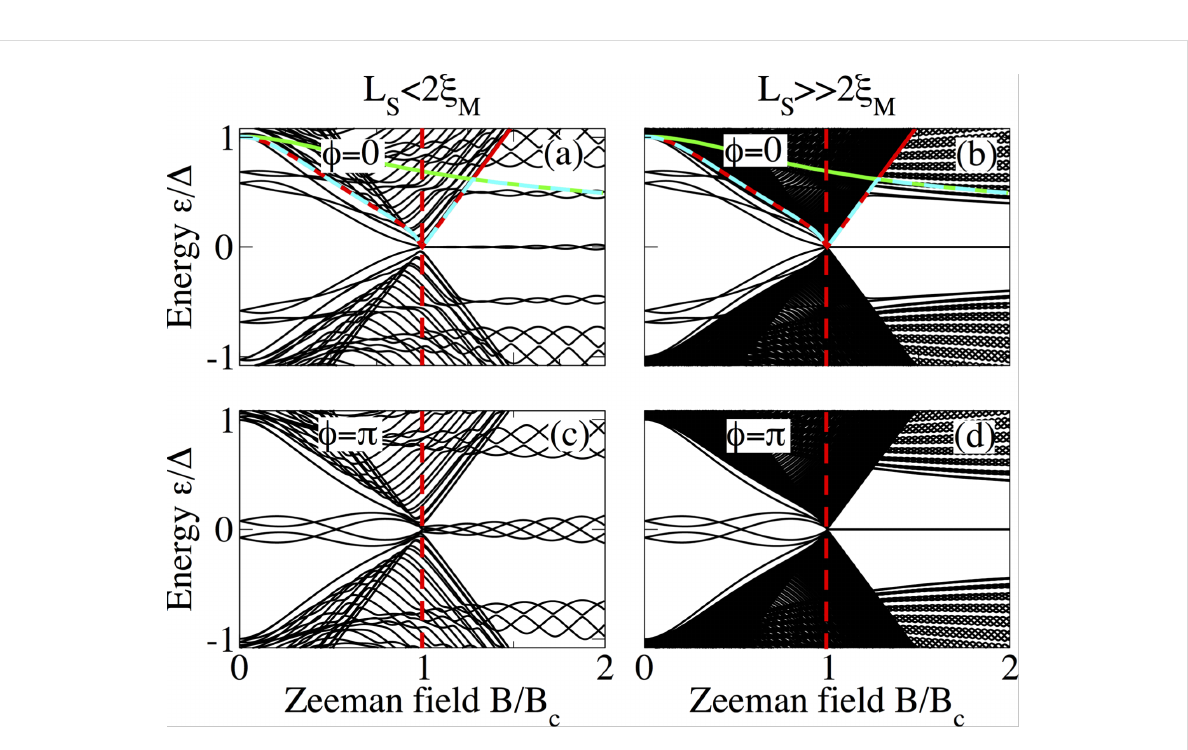
Figure 9: Same as in Figure 8 for an intermediate junction with L N = 400